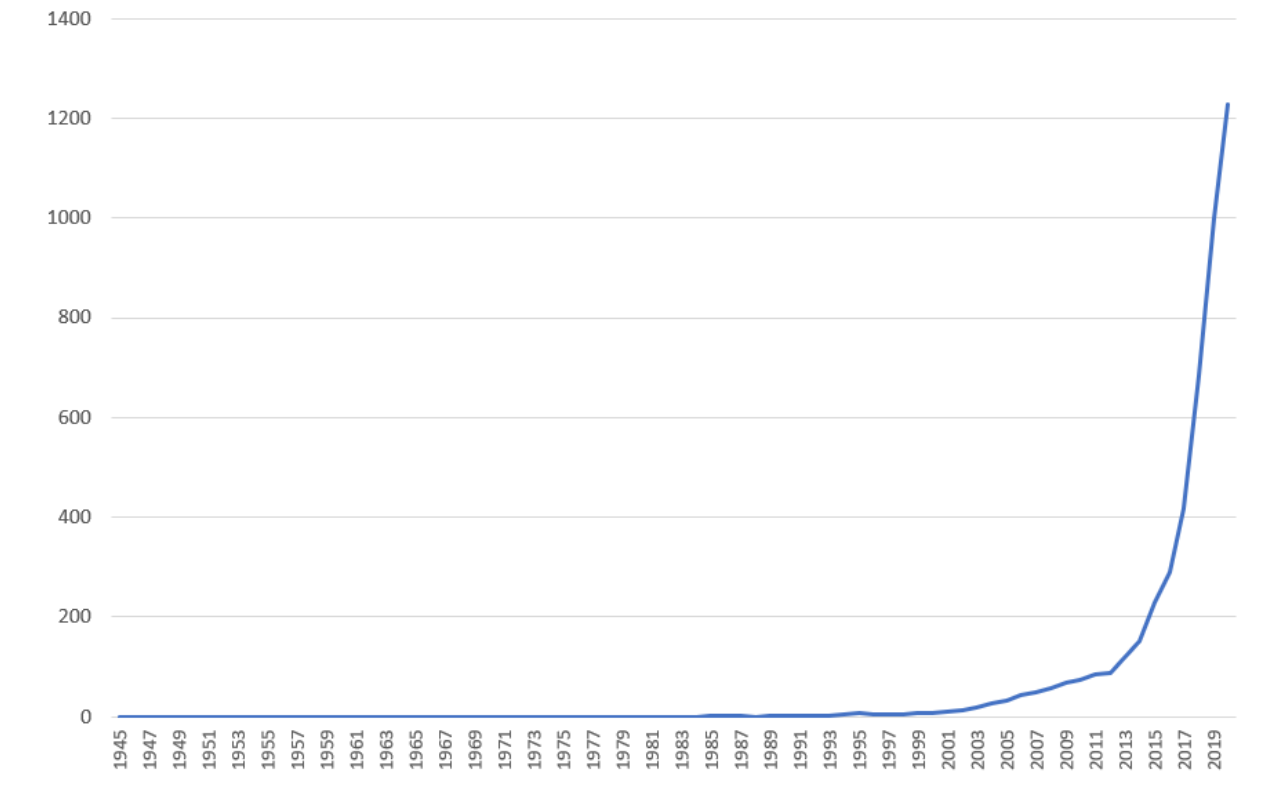
Figure 1. The number of citations that appear on PubMed by year for the following search terms: ("Medical Education" OR "Medical Training") AND ("Artificial Intelligence" OR "Machine Learning" OR "Deep Learning").